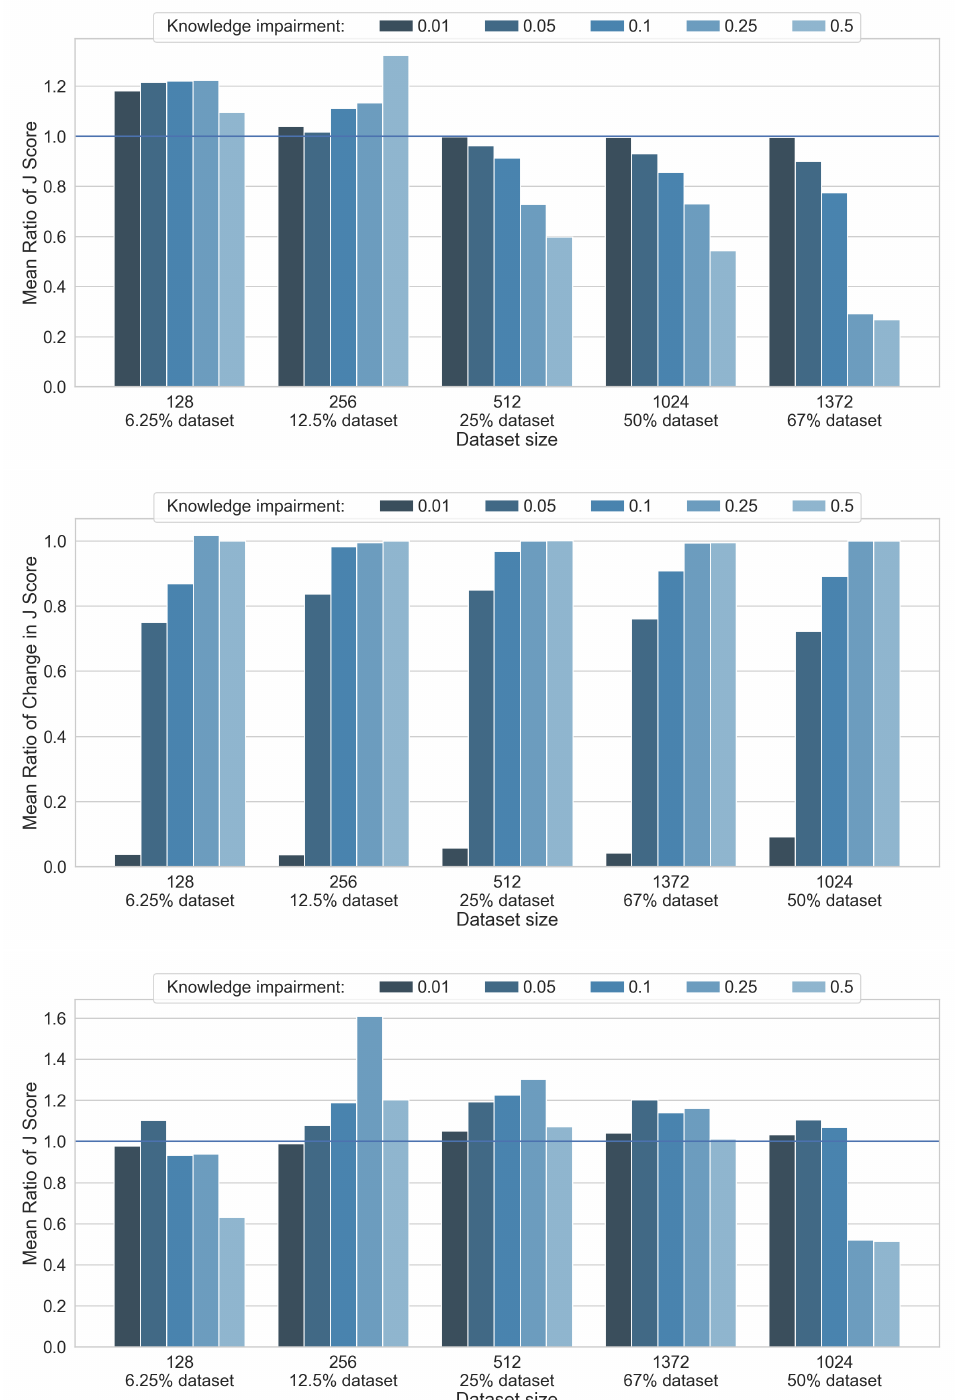
Figure 9. Relative classification accuracy scores for the knowledge subnetwork of hybrid network, learned performance of L-neuron-only network and the comparison between the performance of knowledge subnetwork of hybrid network and L-neuron-only network . ( Top ) Relative performance J H L / J H . ( Middle ) Relative performance: ( J L − J L 0 ) / J L . ( Bottom ) Relative performance: J H L / J L . J H L denotes performance of hybrid network’s knowledge sub-network, J L 0 —initial performance of L-neuron-only network. Confidence intervals of 95% are marked with